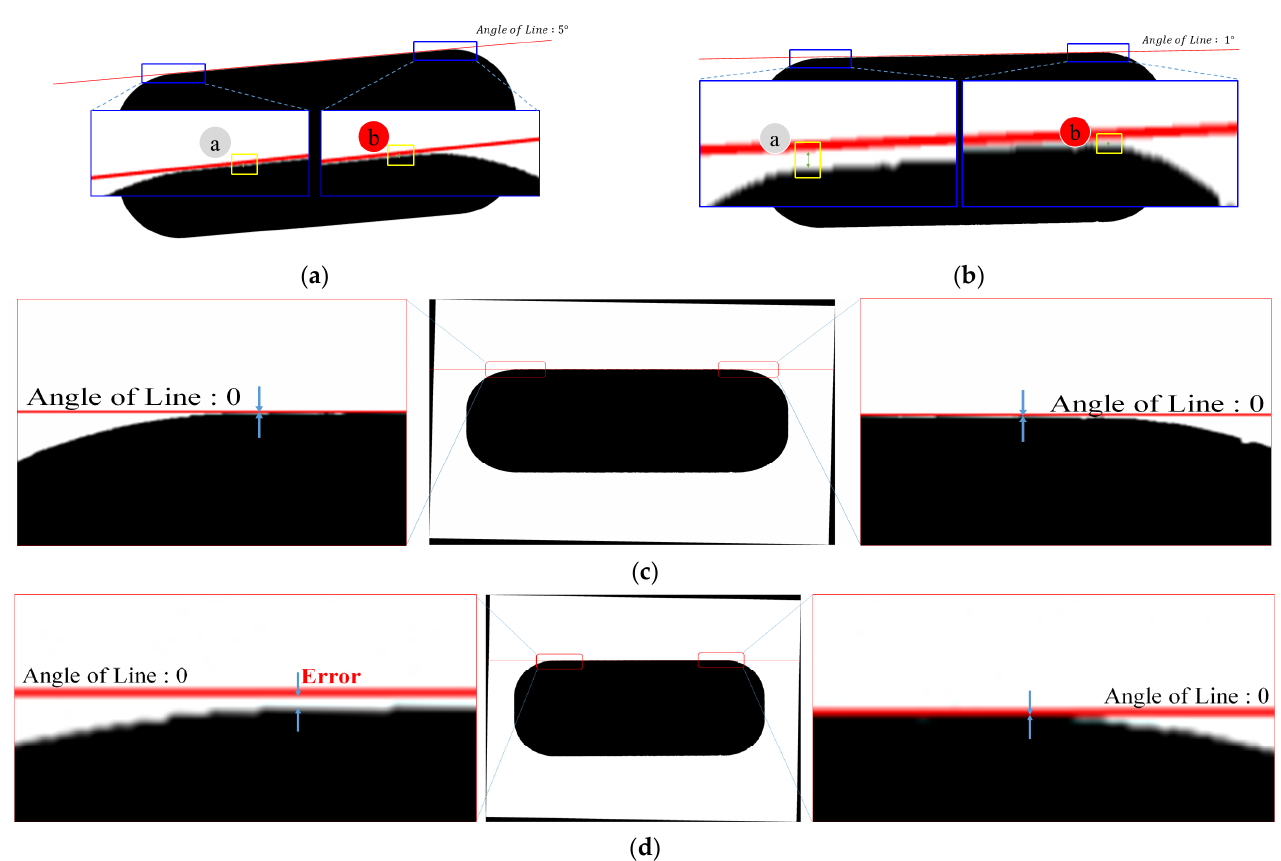
Figure 24. Analysis results: ( a ) Image No. 6 ( ⓐ : error A, ⓑ : error B); ( b ) Image No. 46 ( ⓐ : error A, ⓑ : error B). ( c ) After reverse rotation by the angle measured by the proposed method. ( d ) After reverse rotation by the angle measured by the line-based method.